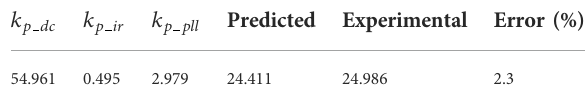
TABLE 9 Optimal parameter combination based on RSM.